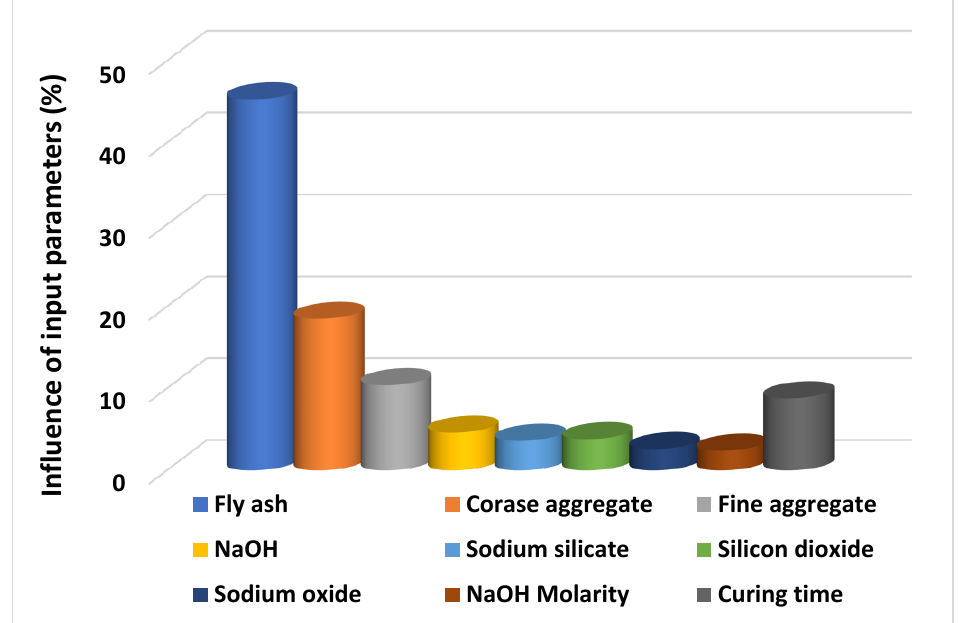
Figure 10. Influence of input parameters towards the prediction of outcome (CS) of GPC.